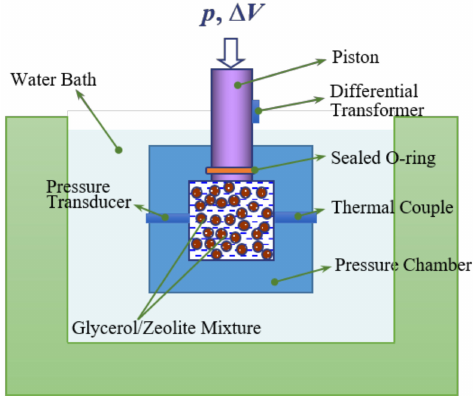
Figure 1. Schematic of experimental